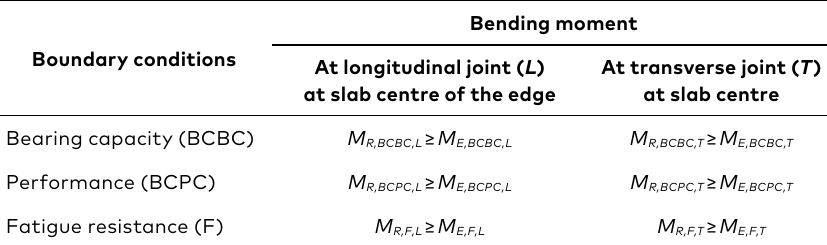
Table 4. Boundary conditions for concrete pavement